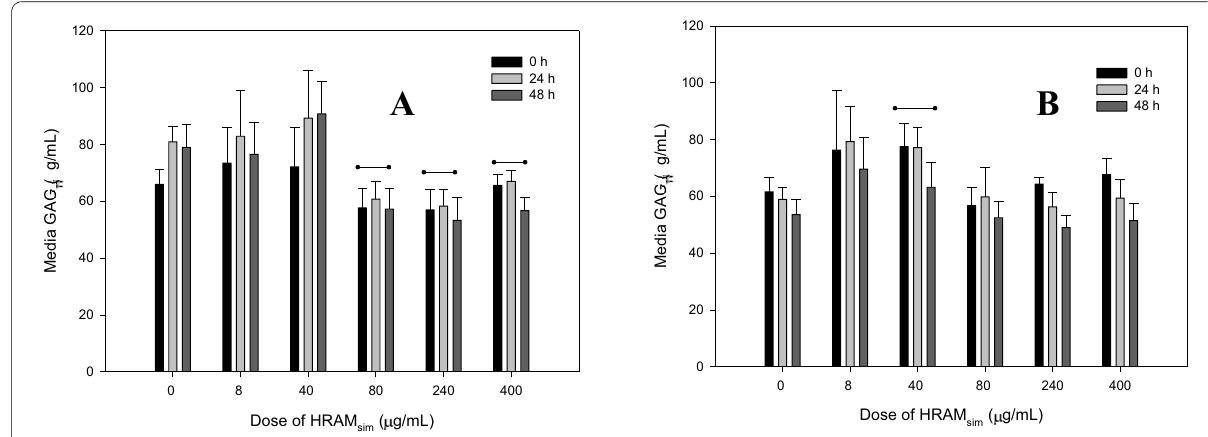
Figure 4 Glycosaminoglycan [GAG] production by cartilage explants stimulated with LPS [3 or 0 μg/mL; Panels A and B, respectively] . Ex- plants were conditioned with HRAM sim [0, 8, 40, 80, 240 or 400 μg/mL] for 96 h, and were stimulated with LPS for the final 48 h. Data shown are for the final 48 hours only. * represents significant effect of LPS; -- represents treatments significantly different from